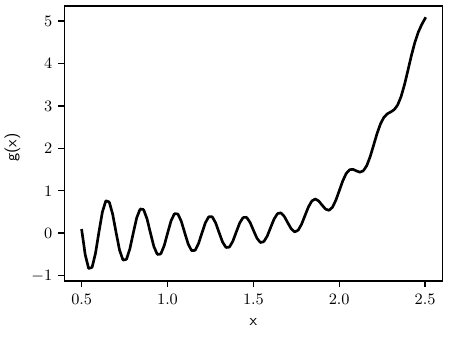
Figure 16. Graph of g ( x )